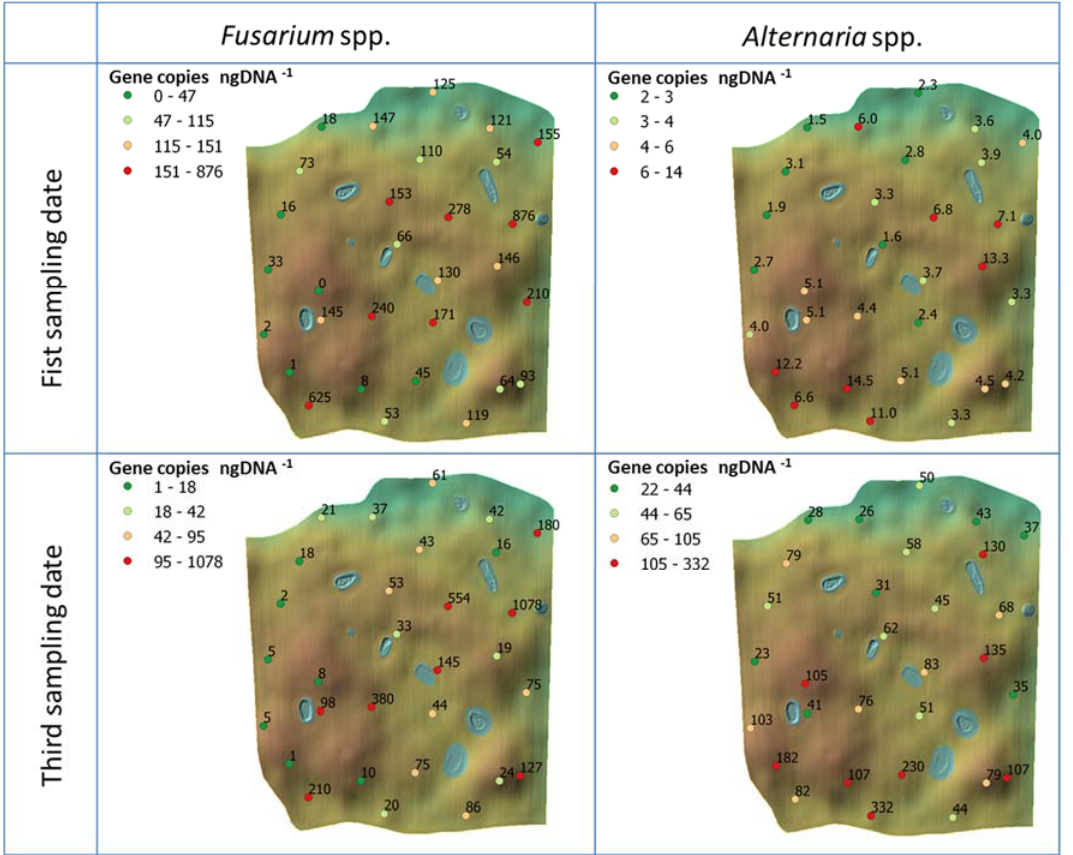
Figure 5. Field maps with specific values of the genetic abundance for both Fusarium and Alternaria fungi measured at each point in the field at each sampling date (only first and third for the genetic abundance). Colours are based on the gene copies number per nanogram DNA − 1 and are classified in quartiles.